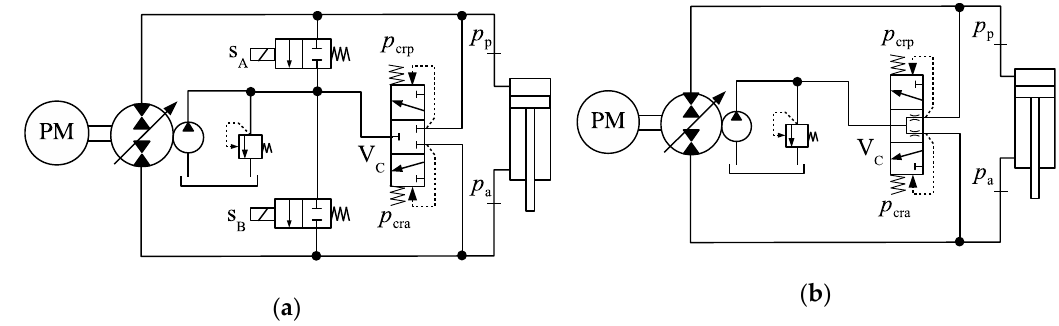
Figure 7. Circuits using 3 × 3 directional valves: ( a ) circuit proposed in reference [11]; ( b ) circuit proposed in reference [12].